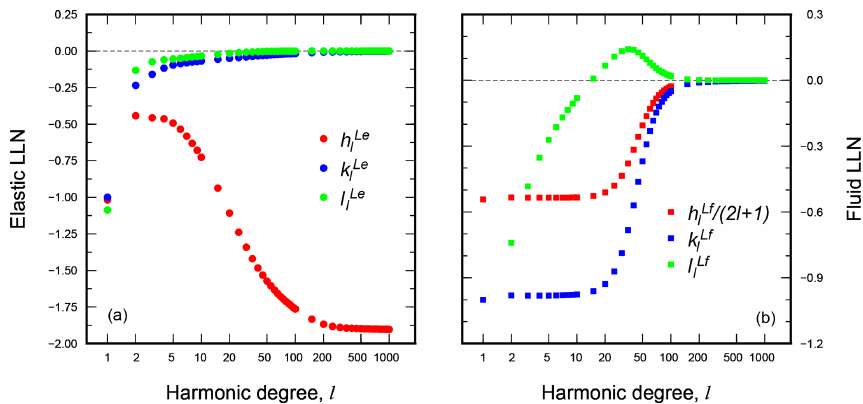
≈ ( 2 l + 1 )k Lf is apparent. l l